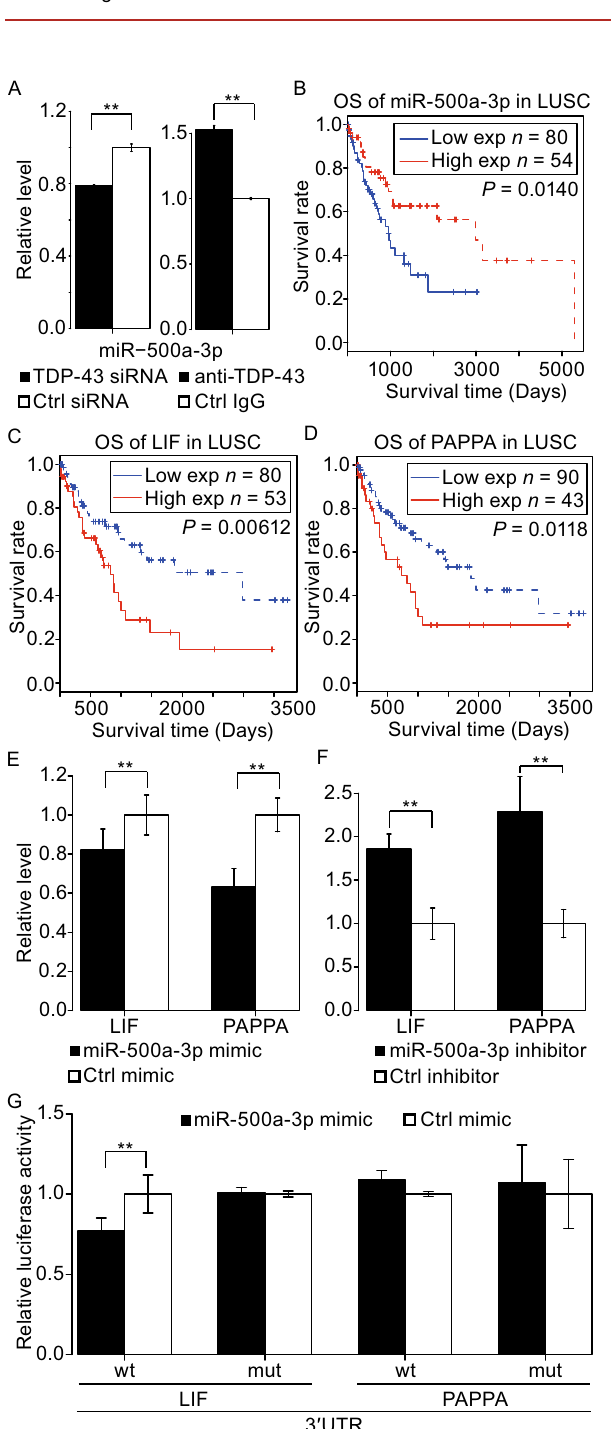
Figure 6. Overall survival analyses of miR-500a-3p and its target genes in lung cancer. (A) Effect of TDP-43 depletion on miR-500a-3p expression level in H1299 cells as determined by qRT-PCR (left panel). Interaction between TDP-43 and miR-500a-3p as assayed by RIP- coupled qRT-PCR (right panel). ( n = 3; means ± SEM; ** P < 0.05). (B) Overall survival analysis for miR-500a-3p in LUSC. (C and D) Overall survival analysis for the miR- 500a-3p target genes LIF (C) and PAPPA (D) in LUSC. P -values from log-rank test. (E and F) MiR-500a-3p represses endogenous expression of LIF and PAPPA in H1299 cells. Over expression of miR-500a-3p represses LIF and PAPPA expression relative to control mimic (E). After transfection of a miR-500a-3p inhibitor,